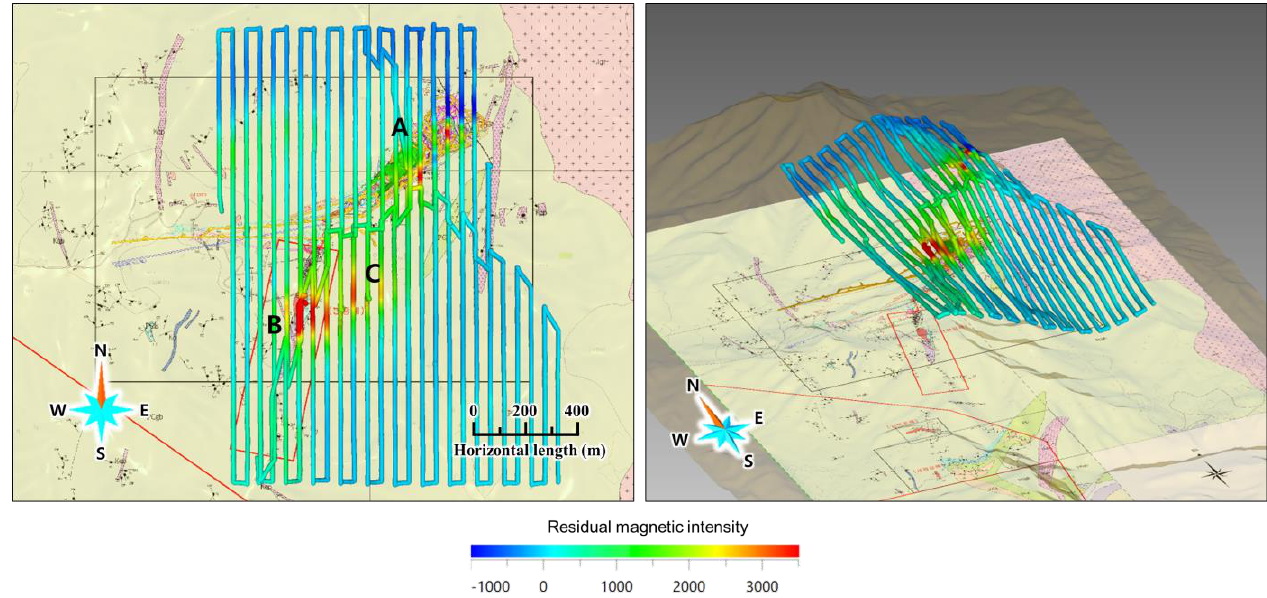
Figure 5. Aeromagnetic survey results using multicopter in 2020.